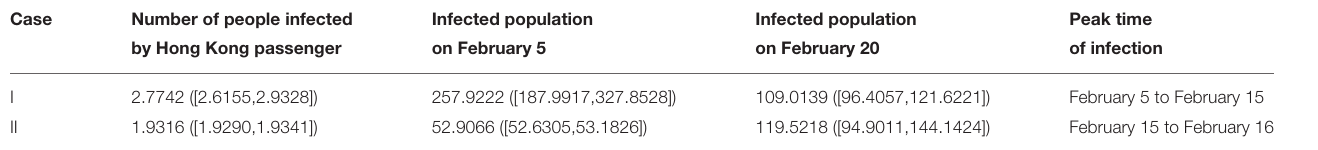
TABLE 3 | Reverse-predicted infection size and peak in Cases I and II.